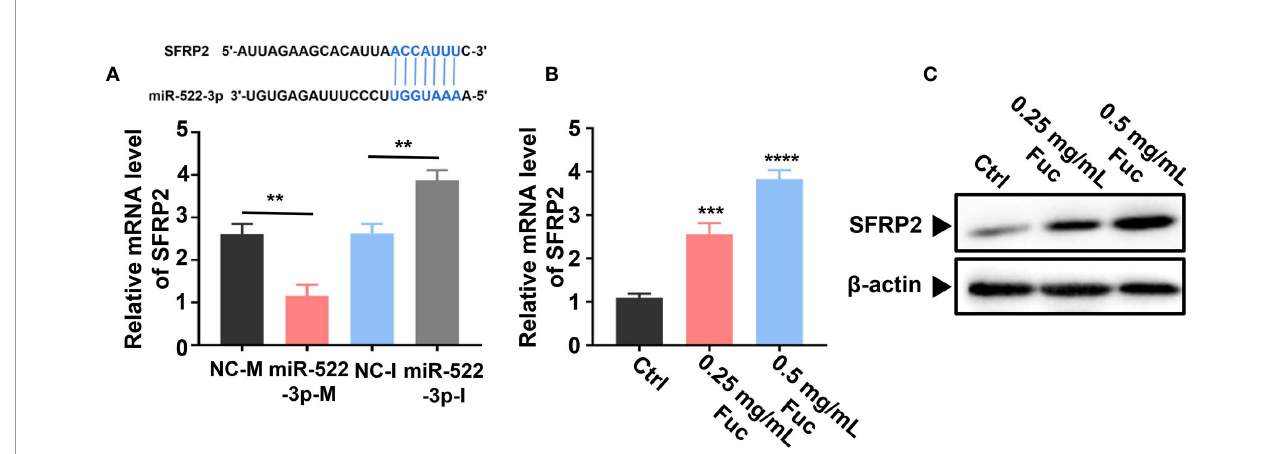
FIGURE 9 | Fucoidan regulates SFRP2 via miR-522-3p. (A) miR-522-3p binds to SFRP2 by base pairing. miR-522-3p-M down-, miR-522-3p-I up-regulates the expression level of SFRP2. ** means P < 0.01. (B) Fucoidan obviously increases the level of SFRP2. *** means P < 0.001, **** means P < 0.0001. (C) Western blots analysis of SFRP2 in MHCC-97H cells treated with different dosages of fucoidan (0, 0.25, 0.5